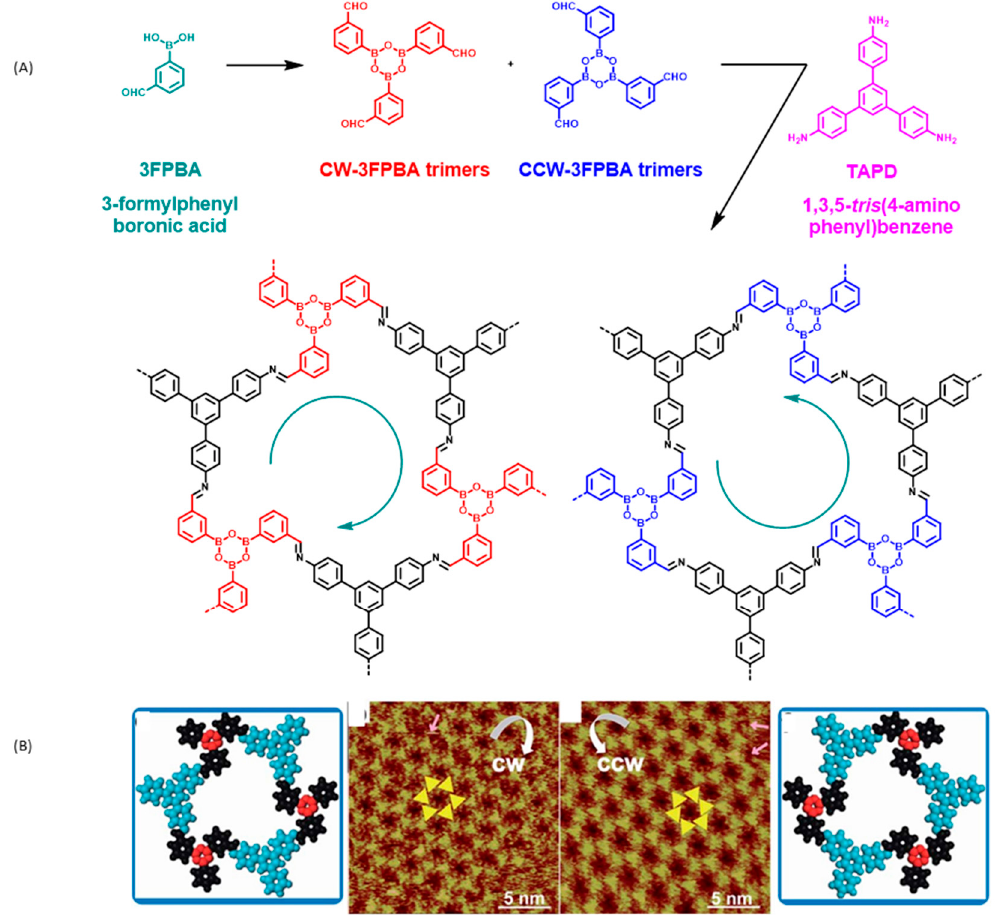
Figure 14. ( A ) Reaction involved in the polymerization process. Clockwise (CW) and counter-clockwise (CCW) rotating 3FPA trimers. ( B ) STM topographs of the sCOF obtained with 3-formylphenylboronic acid (3FPBA) and 1,3,5- tris (4-aminophenyl)benzene (TAPB), and the demonstration of the presence of two chiral phases. Reproduced from [97] with permission from The Royal Society of Chemistry.